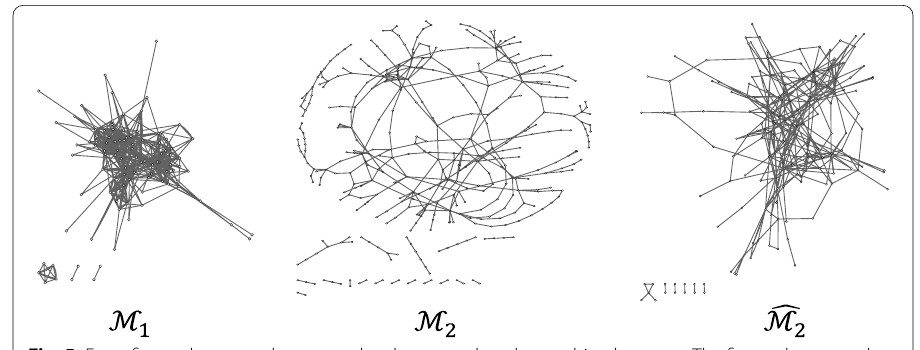
Fig. 5 From first-order network to second-order network and everything between. The first-order network M 1 (left), the lumped second-order network ˆ M 2 (middle), and the second-order state node network M 2 (right) ordered by scale of model